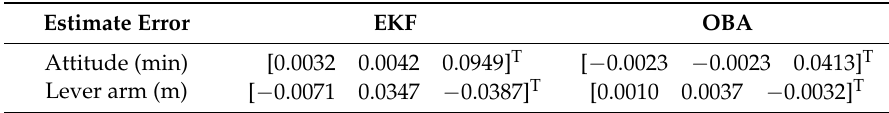
Figure 7. The estimation of lever arm. The red solid line denotes the estimation by OBA, and the blue dashed line denotes the estimation by EKF. The three figures are the lever arm of x axis, y axis and z axis respectively. Table 1. The estimate results of typical motion simulation.